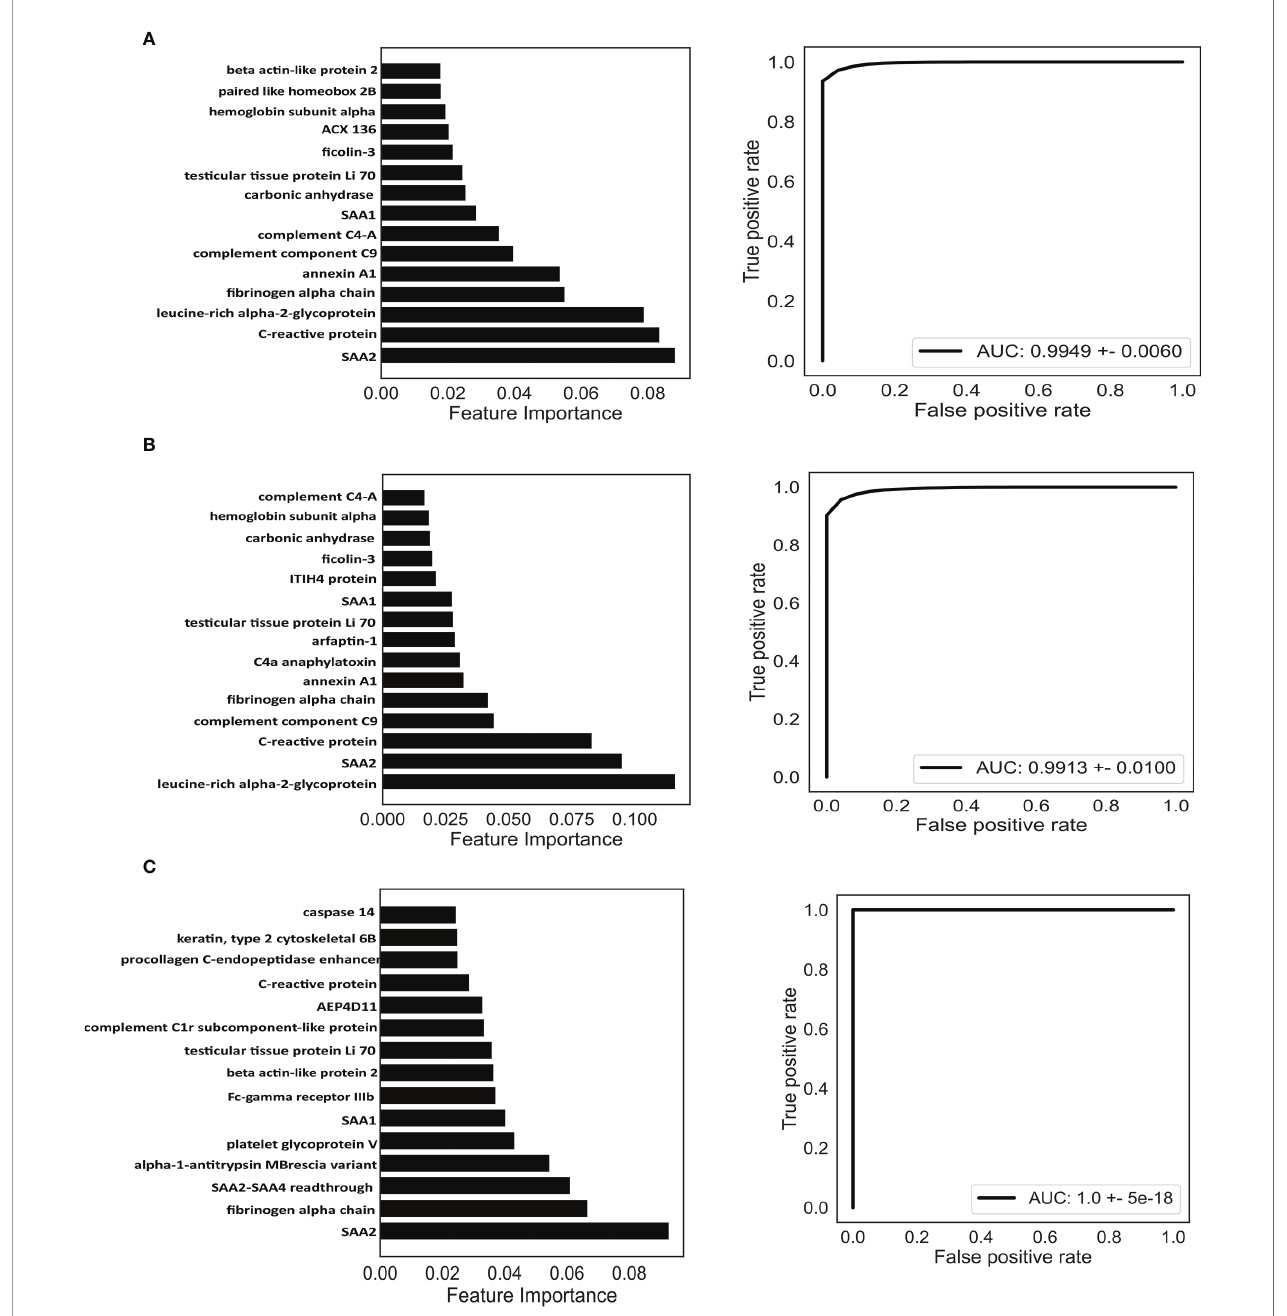
FIGURE 6 | Identi fi cation of potential biomarkers based on machine learning. Classi fi cation of RA (A) , ACPA-positive RA (B) , and ACPA-negative RA (C) . Top 15 proteins prioritized by random forest analysis (left). ROC of the random forest model in the test cohort (right). AUC, area under